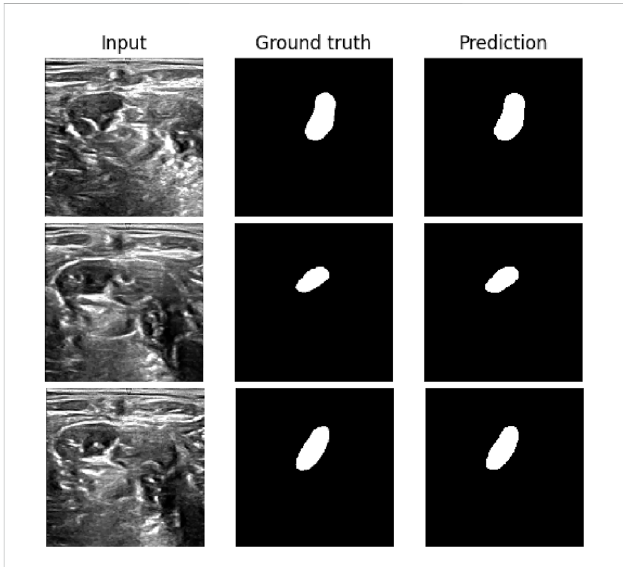
FIGURE 8 Ultrasound images of the neck as input on the left side, center shows the hand annotated nerve, right side shows the prediction by the model. These are some of the best